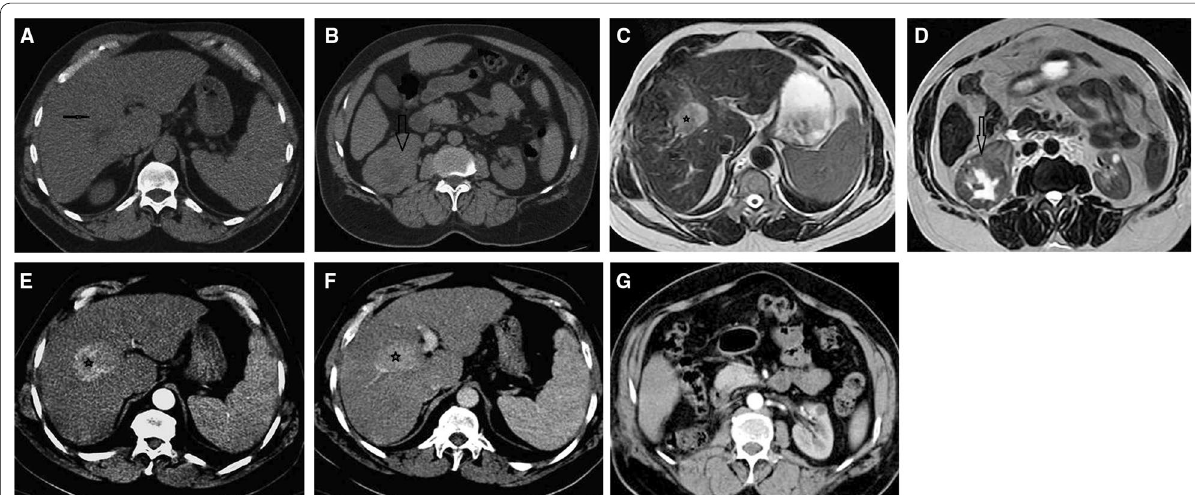
Fig. 1 64‑year‑old male patient with a history of chronic liver disease presented with hematuria. a, b Initially, an unenhanced MDCT scan due to high serum creatinine (contra‑indication for contrast study) revealed an ill‑defined right liver lobe (thin arrow) and right renal mass (arrow). c, d T2 magnetic resonance image revealed hepatic focal lesion (star) (pathologically proved HCC) and right renal mass (arrow) (pathologically proved RCC). The patient underwent a right nephrectomy. e–g MDCT scan after nephrectomy showed right liver lobe mass (asterisk) with enhancement on arterial phase and washout in portal phase (characteristic of HCC) with right nephrectomy